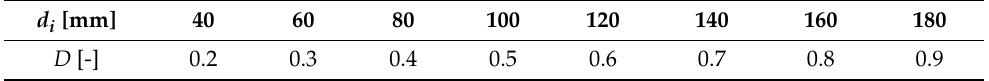
Figure 2. Repeatable insert segment: ( a ) 3D view of a pipe fragment with an insert; ( b ) computational domain; ( c ) channel cross-section diagram. Table 3. Dimensions of the tested insert and the corresponding dimensionless